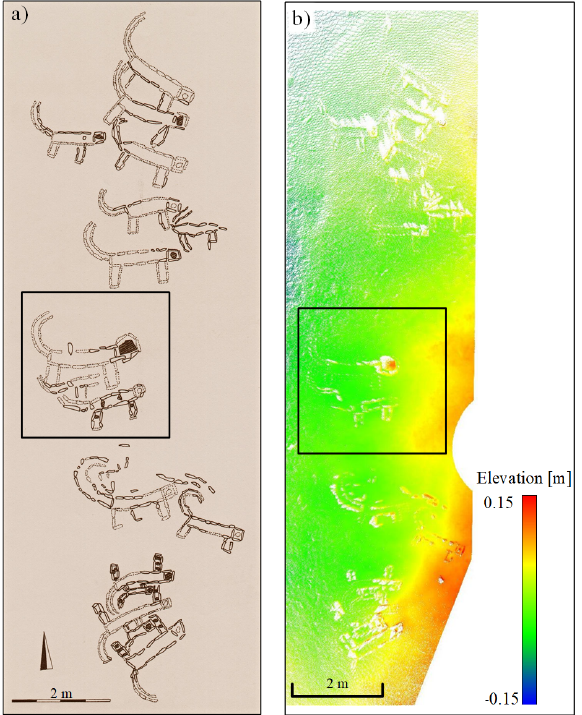
Figure 7. The Leopard Temple: a) site map (with permission of Israel Antiquities Authority c (cid:13) ); b) scanned point-cloud